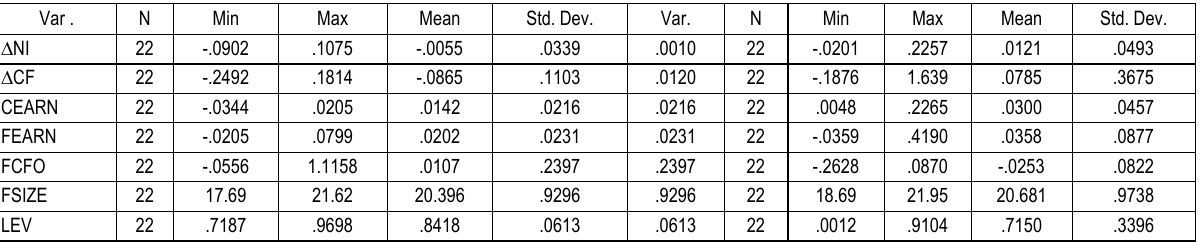
Table 1. Descriptive statistics of test, earnings predictability proxies and control variables used in the analysis